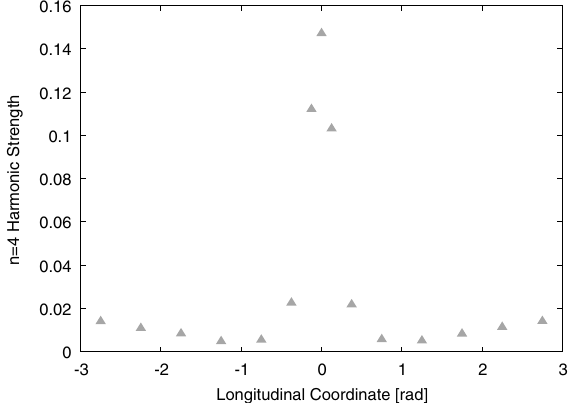
(cid:5) 4 : 0 envelope harmonic versus e